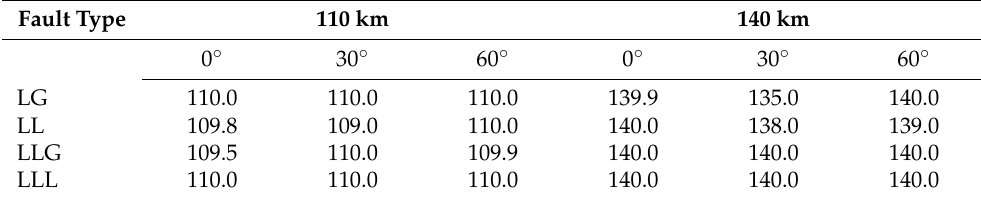
Table 11. Fault estimation at 110 and 90 km with a 20 Ω fault